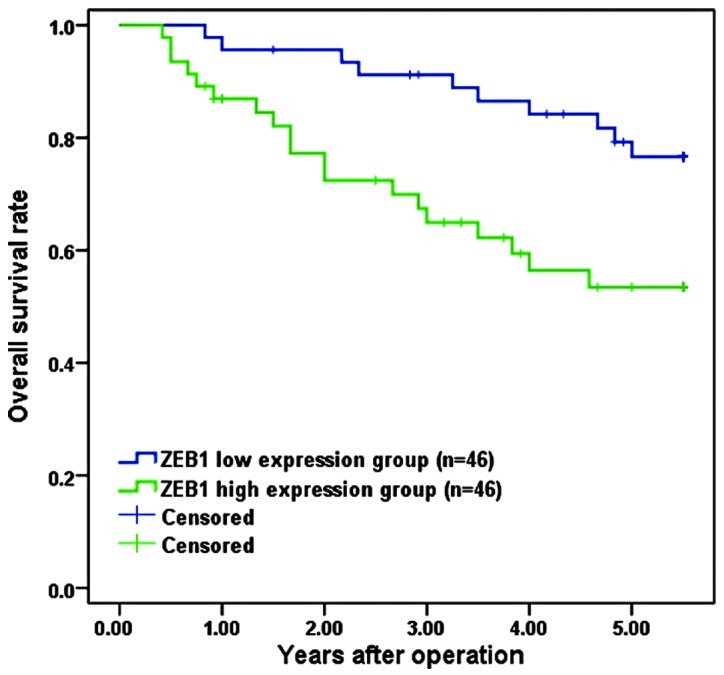
Kaplan-Meier survival curves of patients with colorectal cancer based on zinc finger E-box binding homeobox 1 (ZEB1) expression status. Patients in the high expression group (green line) had significantly poorer prognosis than those in the low expression group (blue line; P= 0.010, log-rank test).